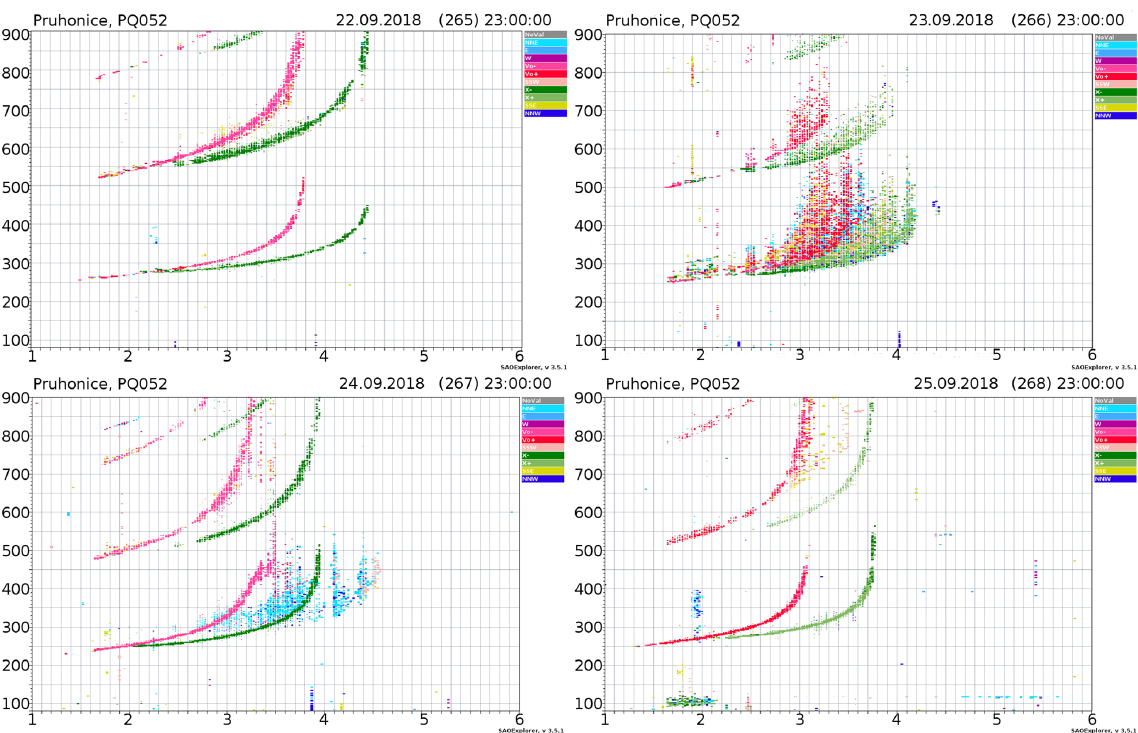
Figure 8. Sequence of ionograms recorded during local night at around 23:00UT presented in a standard DPS-4D format. A particular color indicates the direction of radio wave arrival. The vertical echo of an ordinary wave is marked by red color, while green color stands for an extraordinary wave. Other colors represent non-vertical reflections. The strongest non-vertical echo comes from the north-northeasterly direction (light blue color).